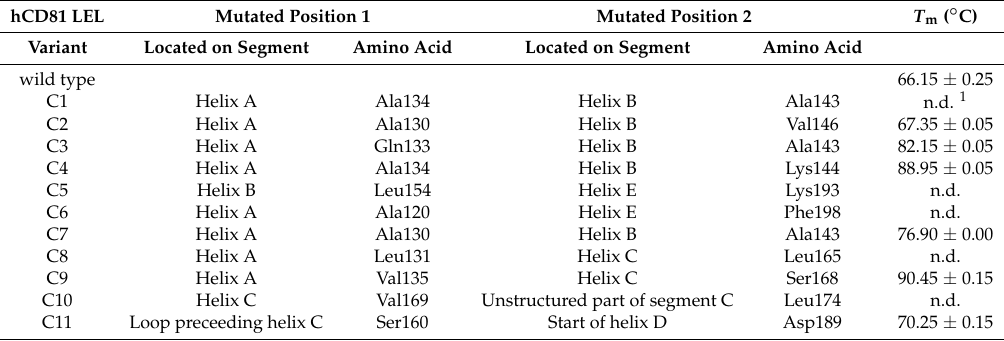
Table 1. Variants of human CD81 large extracellular loop (hCD81 LEL) designed for stabilization with de novo cysteine bonds. Indicated are amino acids that were mutated to cysteine, their position and the measured melting temperature ( T m ).